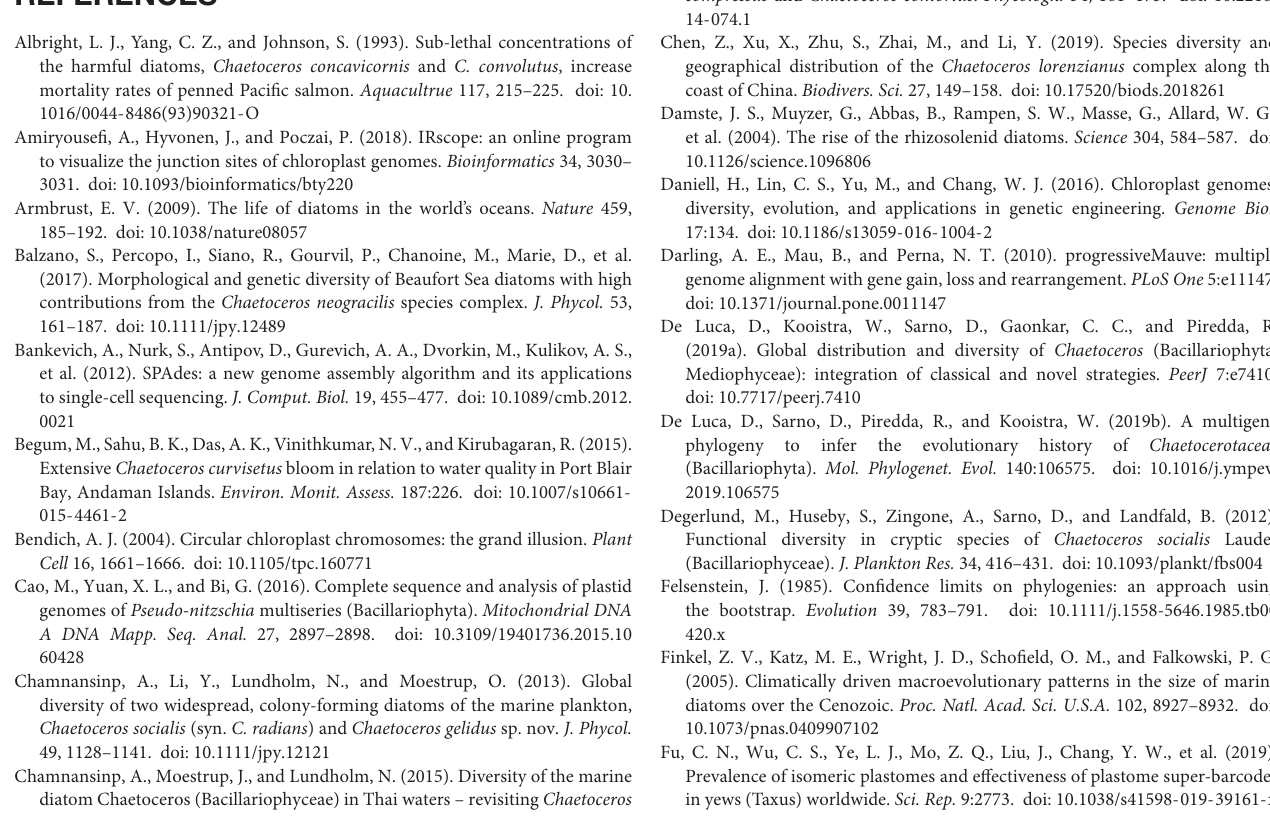
Supplementary Figure 1 | The phylogenetic analysis of Chaetoceros species using full length of (A) rbcL gene and (B) partial 28S rDNA. Supplementary Figure 2 | Gene structural map of the seven Chaetoceros cpDNAs. (A) C. muelleri (strain CNS00047), (B) C. costatus (strain CNS00386), (C) C. socialis (strain CNS00389), (D) C. pseudo-curvisetus (strain CNS00390), (E) C. tenuissimus (strain CNS00394), (F) C. laevisporus (strain CNS00396), and (G) C. curvisetus (strain CNS00516). Supplementary Figure 3 | Phylogenetic trees constructed using different hotspots regions. (A) Position: 19,025–19,624 bp in C. muelleri cpDNA. (B) 106,895–107,700 bp in C. muelleri cpDNA. Supplementary Figure 4 | (A,B) The DNA alignment information of hotspots region (position: 19,025–19,624 bp and 106,895–107,700 bp in C. muelleri cpDNA) for Chaetoceros